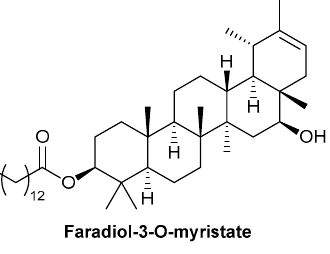
Figure 3. Chemical structure of faradiol-3-O-myristate, one of the major anti-inflammatory triterpe- noid esters from C. officinalis . penoid esters from C. officinalis